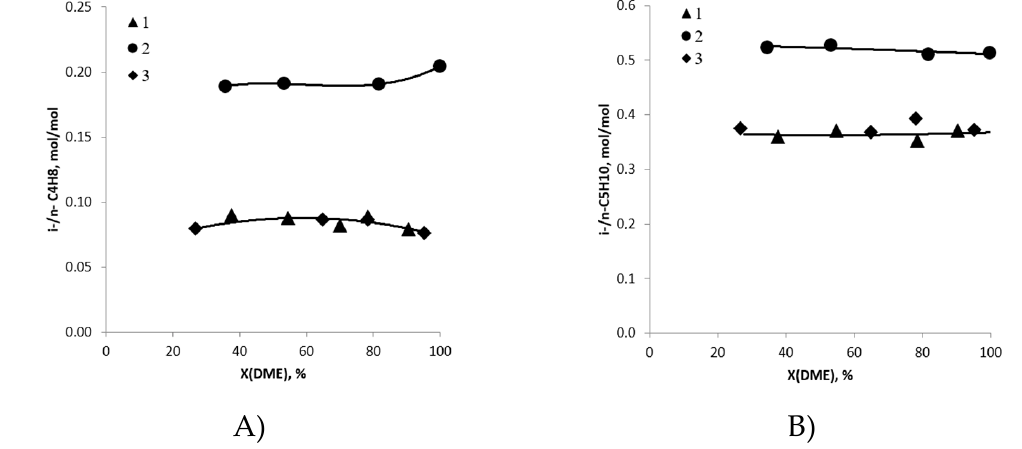
Figure 9. Molar ratio of iso- / n-C 4 -C 5 alkenes as a function of DME conversion (X (DME), %). 1—HZSM-5 / Al 2 O 3 ; 2—Zr-HZSM-5 / Al 2 O 3 ; 3—Mg-HZSM-5 / Al 2 O 3 . ( A ) iso-/n-butenes; ( B ) iso-/n- pentenes.